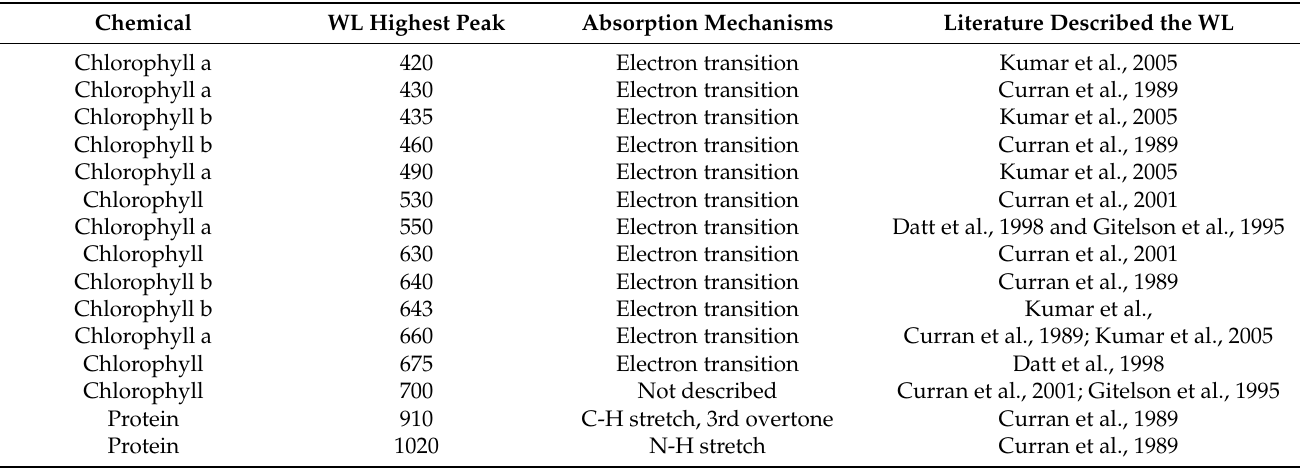
Table A3. Specific absorption bands related to plant chlorophyll a and b combined, chlorophyll a, or chlorophyll b and protein and the respective absorption mechanisms described in literature (Curran et al., 1989; Gitelson et al., 1995; Datt et